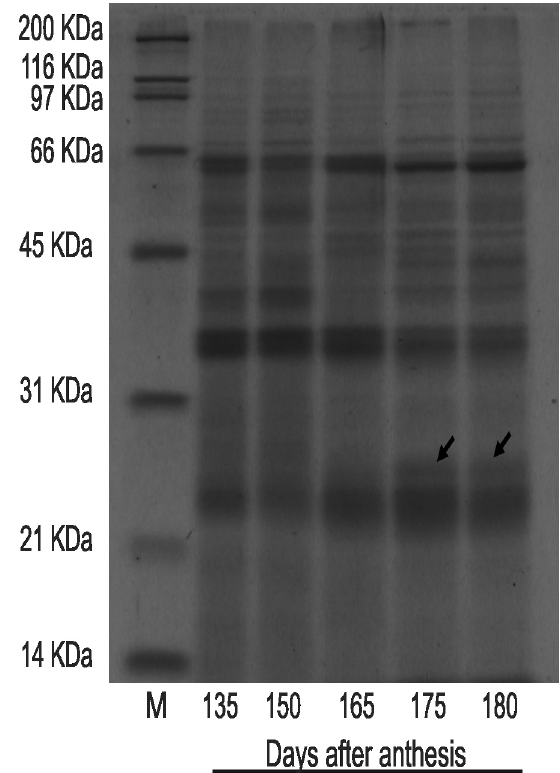
Figure 3 - Electrophoretic profile of low molecular weight heat shock proteins (smHRPs) in embryonic axes of rubber tree seeds harvested at 135, 150, 165, 175 and 180 days after anthesis. M - molecular marker. The arrows indicate the similarity among the seeds immediately before the dispersion and recently